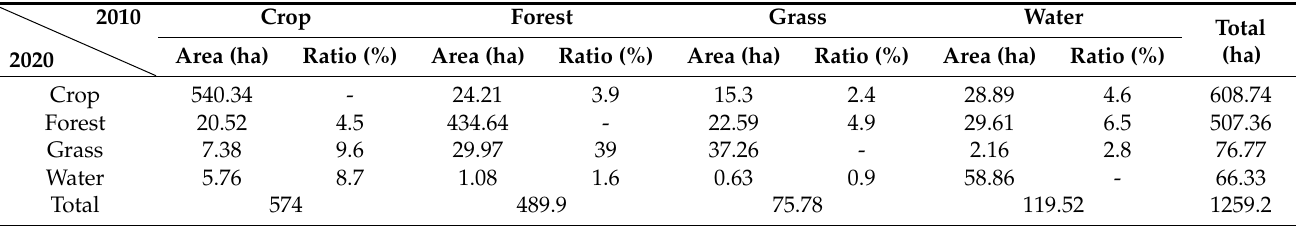
Table 4. Land cover transfer matrix from 2010 to